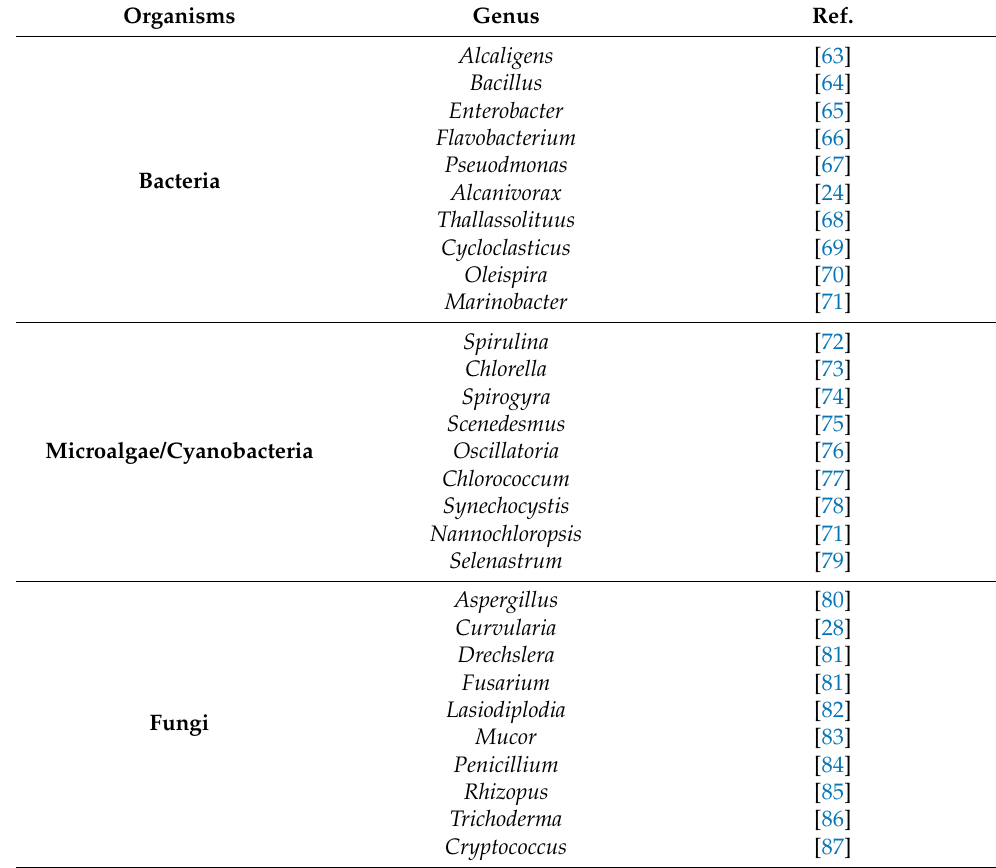
Table 1. List of the principal genera of bacteria, microalgae and fungi involved in bioremediation. Organisms Genus